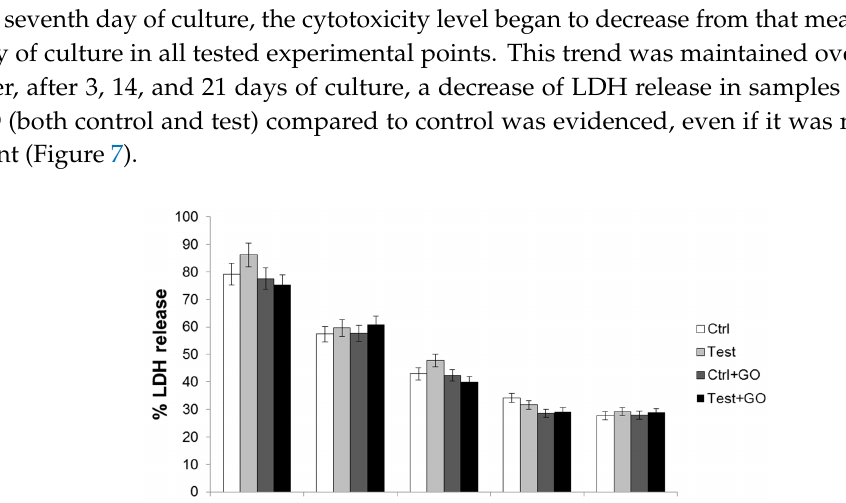
Figure 6. 3-[4,5-dimethyl-thiazol-2-yl-]-2,5-diphenyl tetrazolium bromide (MTT ) assay in DPSCs cultured on Ti discs for 3, 7, 14, 21, and 28 days. The histogram represents optical density (OD) values in control, test, control + GO, and test + GO discs. Data shown are the mean (± SD) of three separate experiments. * Day 7: test + GO vs. control, test, control + GO p < 0.01. * Day 14: test + GO vs. control, test p < 0.05. *Day 28: test vs. control p < 0.05.